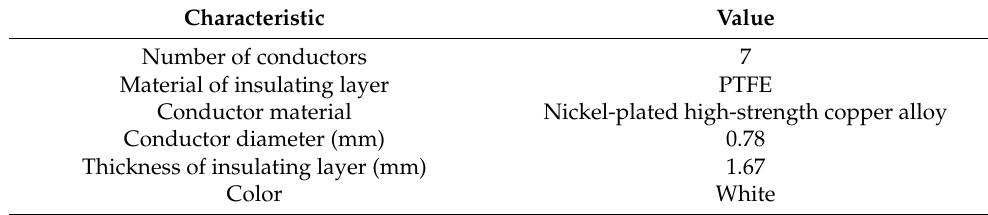
Table 4. Parameters of the Group #2 cables.